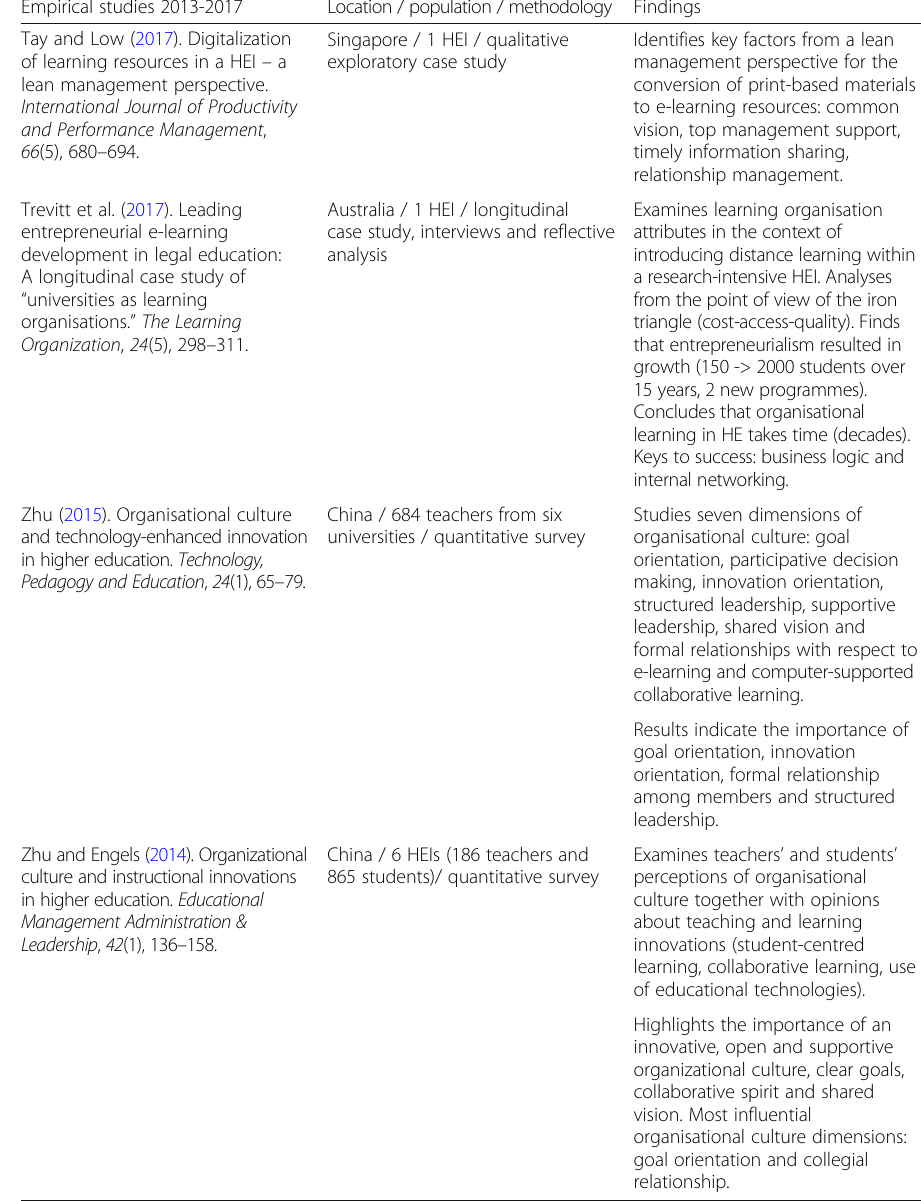
Table 2 Results: Empirical studies